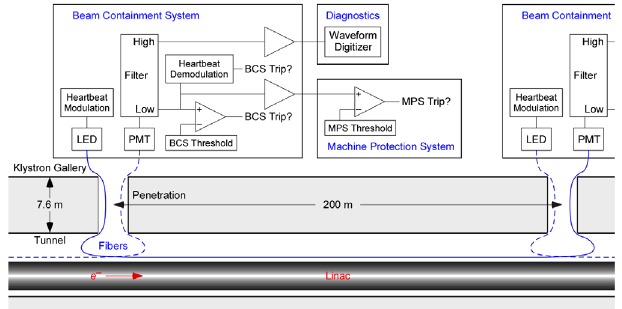
FIG. 7. Typical fiber layout in the linac tunnel, including the PMT at the downstream end and the heartbeat LED at the upstream end. The splitter that provides a signal for three functions is indicated. A solid line indicates the fiber path between the two penetrations shown; the two fibers running beyond this region are shown with dashes. FIG. 8. Simulated signal (nA =W ) integrated along the fiber as a function of the horizontal distance to the loss point. The upper trace shows loss on a target of medium thickness (e.g., a protection collimator); the lower traces shows a thick